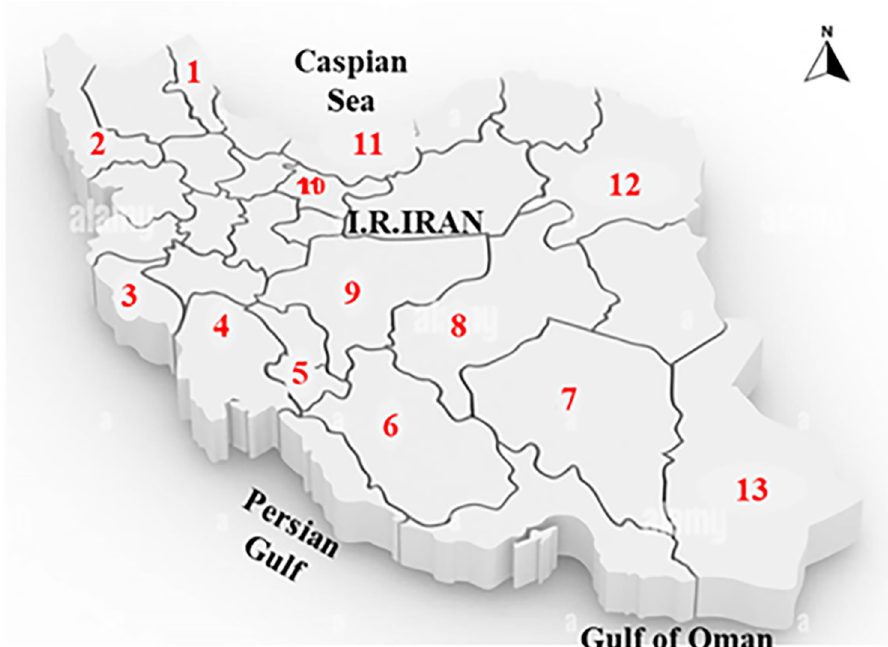
Fig 1. Map of sampling sites for B . germanica and P . americana across Iran. Numbers are 1: Ardabil, 2: West Azarbaijan, 3: Ilam, 4: Khuzestan, 5: Kohgiluye and Boyer-Ahmad, 6: Fars, 7: Kerman, 8: Yazd, 9: Isfahan, 10: Tehran, 11: Mazandaran, 12: Razavi Khorasan, 13: Sistan and Baluchestan. Reprinted from Choubdar et al 2021 under a CC BY license, with permission from PLOS publisher, original copyright. (https://commons.wikimedia.org/wiki/File:Map_of_ Iran.png).